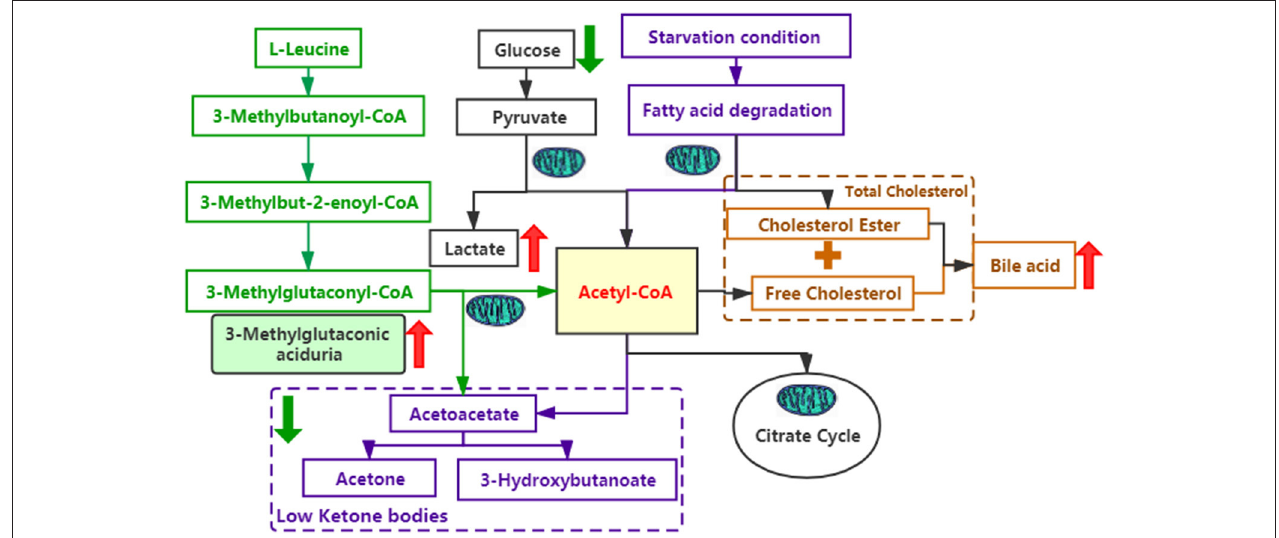
FIGURE 3 | Several metabolic pathways involved in this case. The green font represents the leucine metabolic pathway; the purple font represents the fatty acid metabolic pathway; the black font represents the glucose metabolic pathway; and the yellow font represents the cholesterol metabolic pathway. The red arrows indicate an increase, whereas the green arrows indicate a